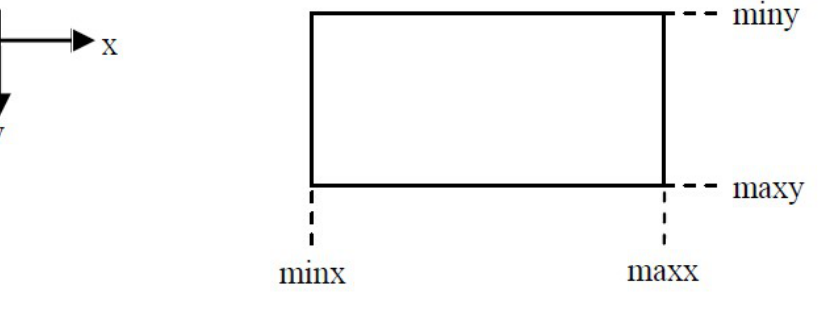
Figure 20. The rectangular clipping window of the KWC